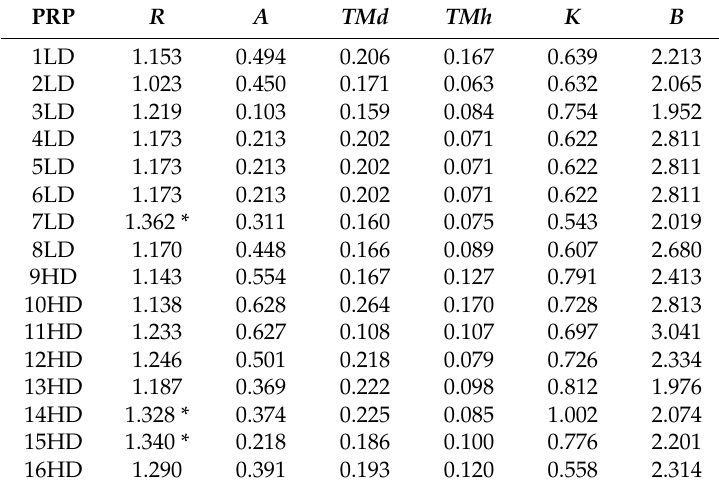
Table 3. Diversity indices of tree layers on permanent research plots 1–16 in 2017 (LD—plots with low game damage; HD—plots with high game damage).